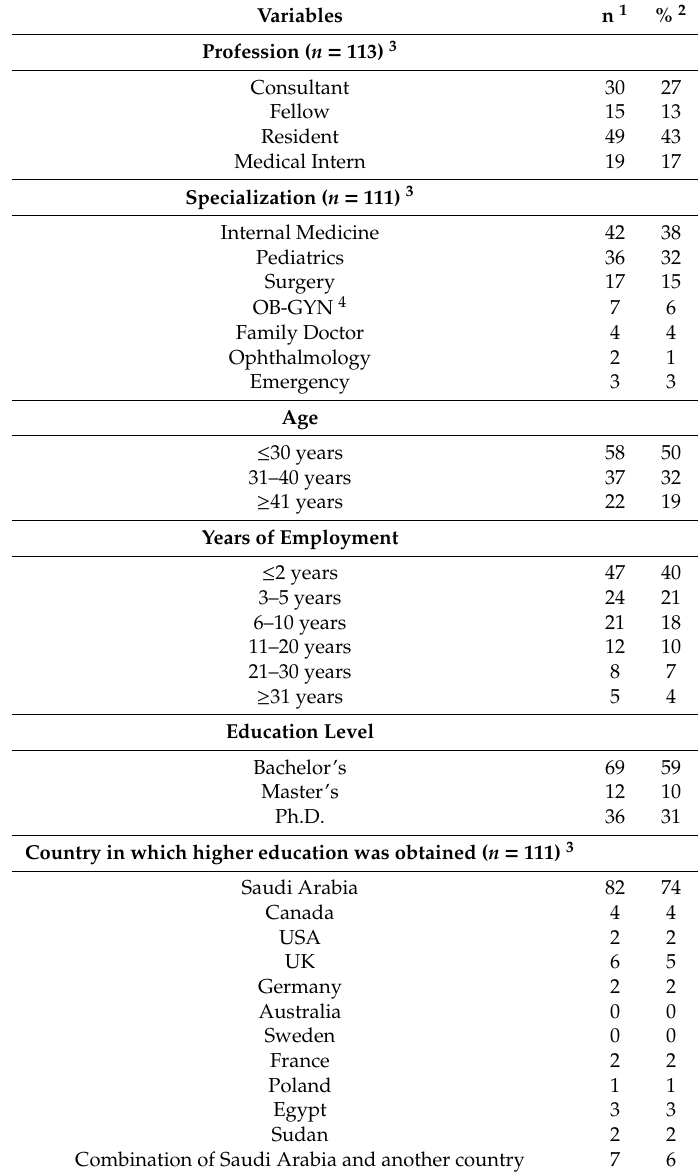
Table 1. Demographic characteristics of the study sample ( n =